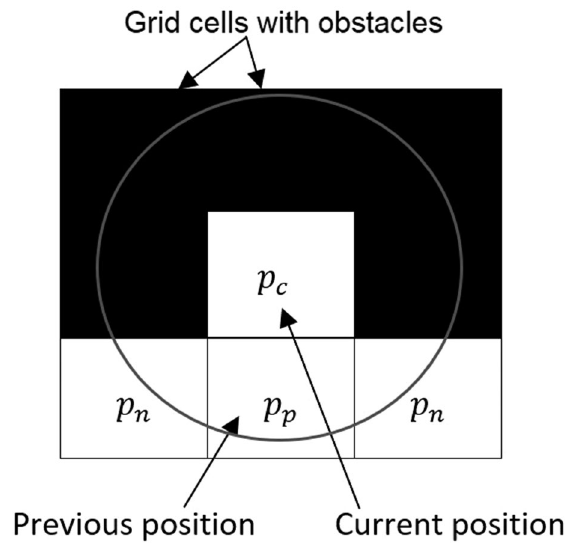
Fig. 2 Representation of a dead-end